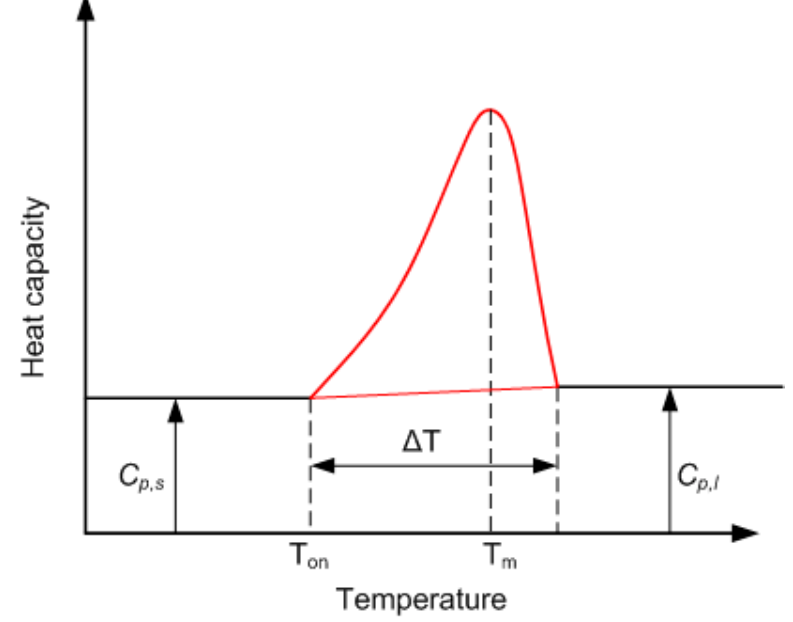
Figure 5. Typical PCM heat capacity profile.